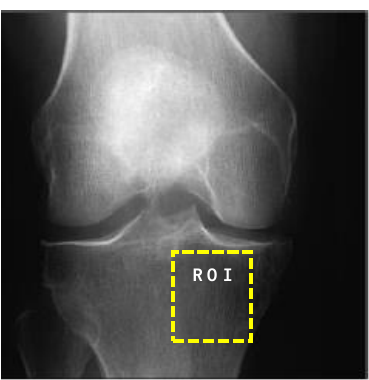
Figure 2. Knee radiographic image